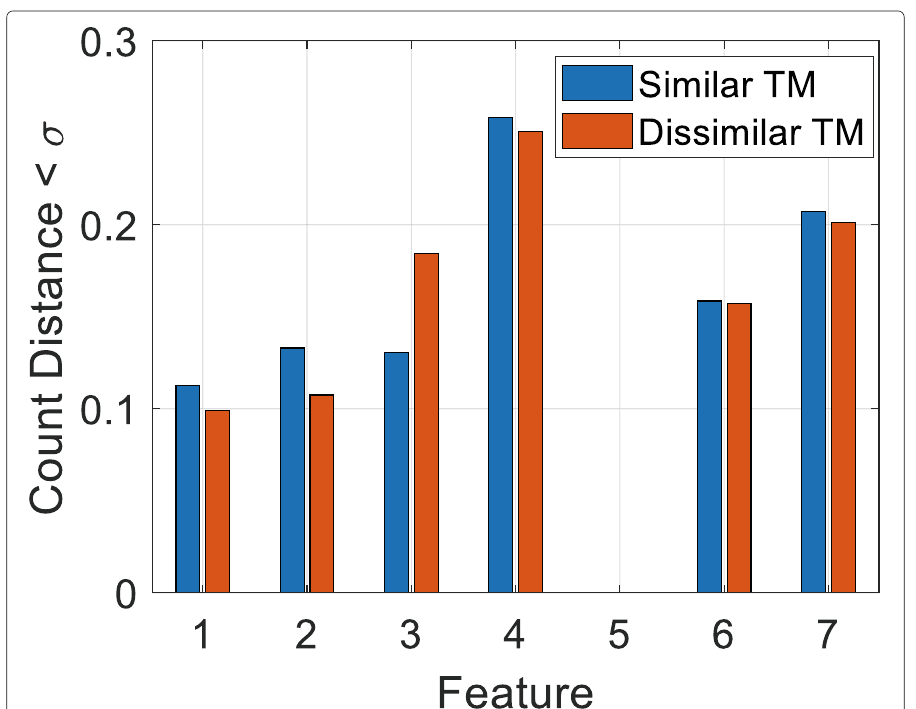
Fig. 4 Statistics where the distance of each feature is less than the standard deviation